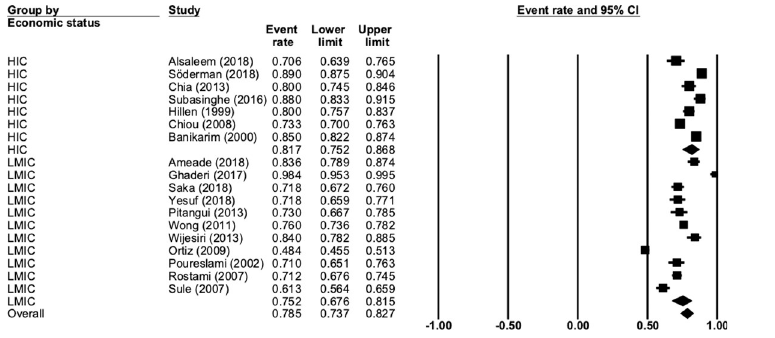
Fig 2. Prevalence of dysmenorrhea by economic